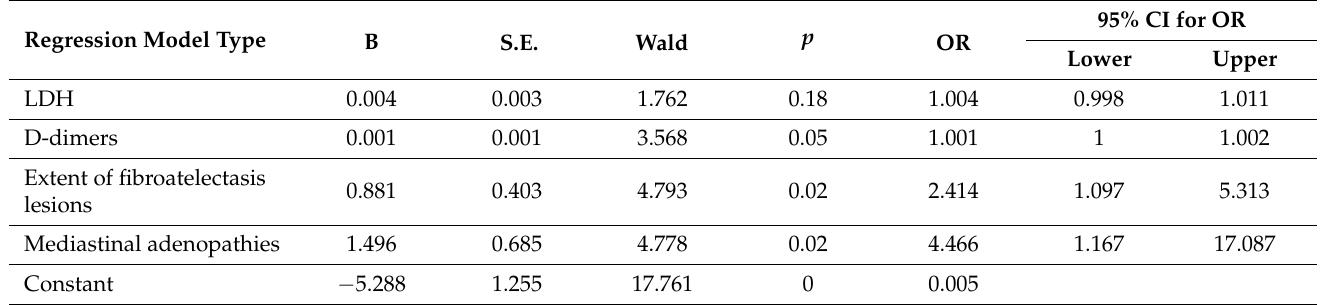
Table 5. Multivariable logistic regression model for patients with myocardial